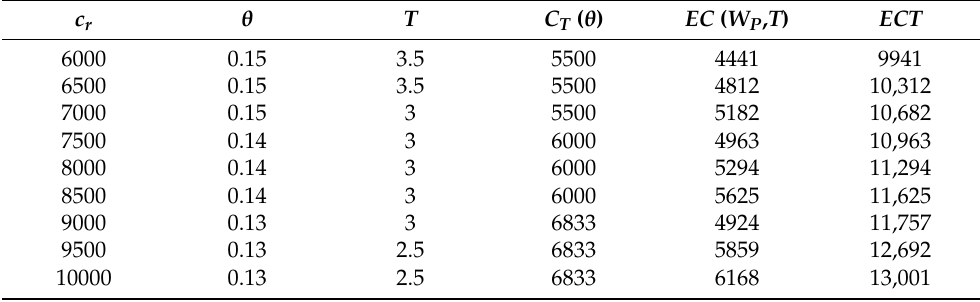
Table 3. Effect of readmission cost on the optimal treatment decision and monitoring